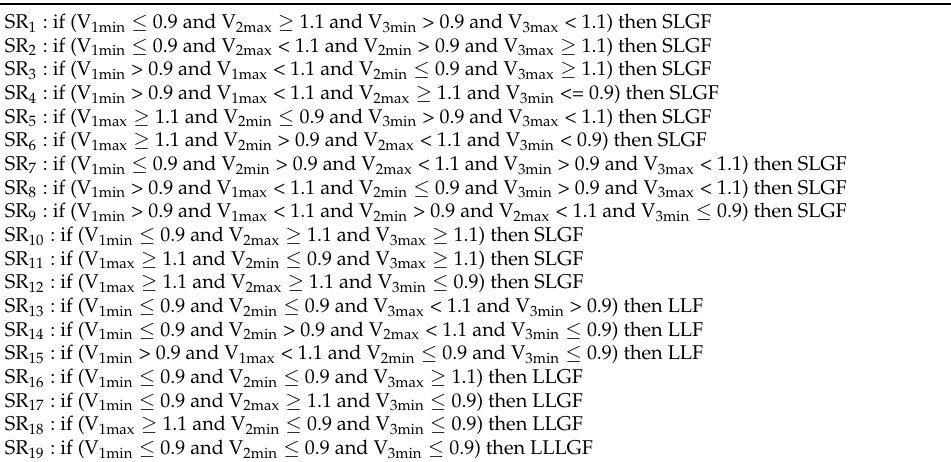
Table 3. Rules of determination of fault type.